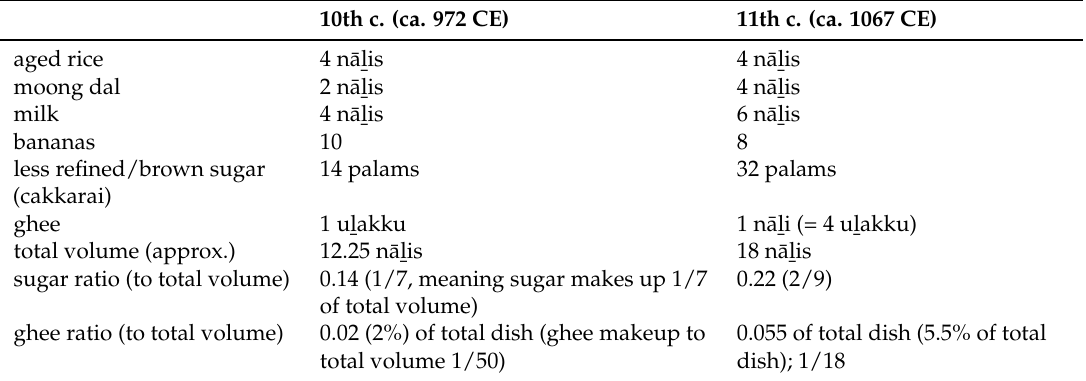
Table 1. Akk¯ara at.icil